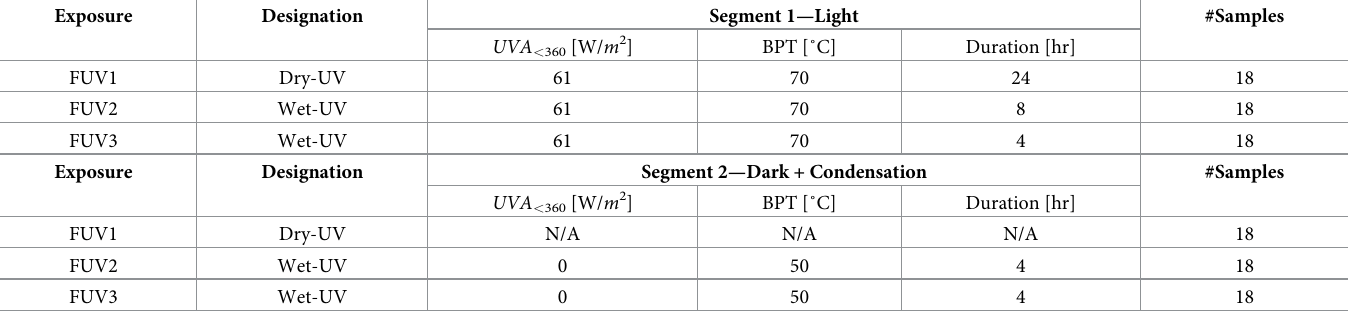
Table 4. Summary of fluorescent ultraviolet lamp exposure conditions. BPT is the black panel temperature. Designations are classifiers used in modeling and cross-cor- relation. “#Samples” is the total number of samples under each exposure condition.